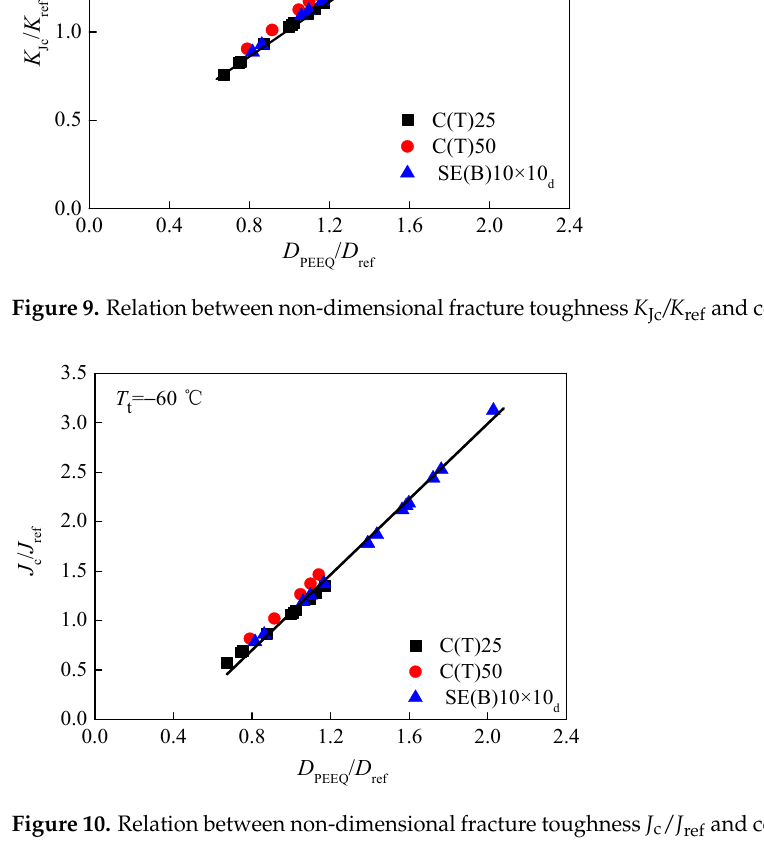
Figure 10. Relation between non-dimensional fracture toughness J c / J ref and constraint parameter D p .